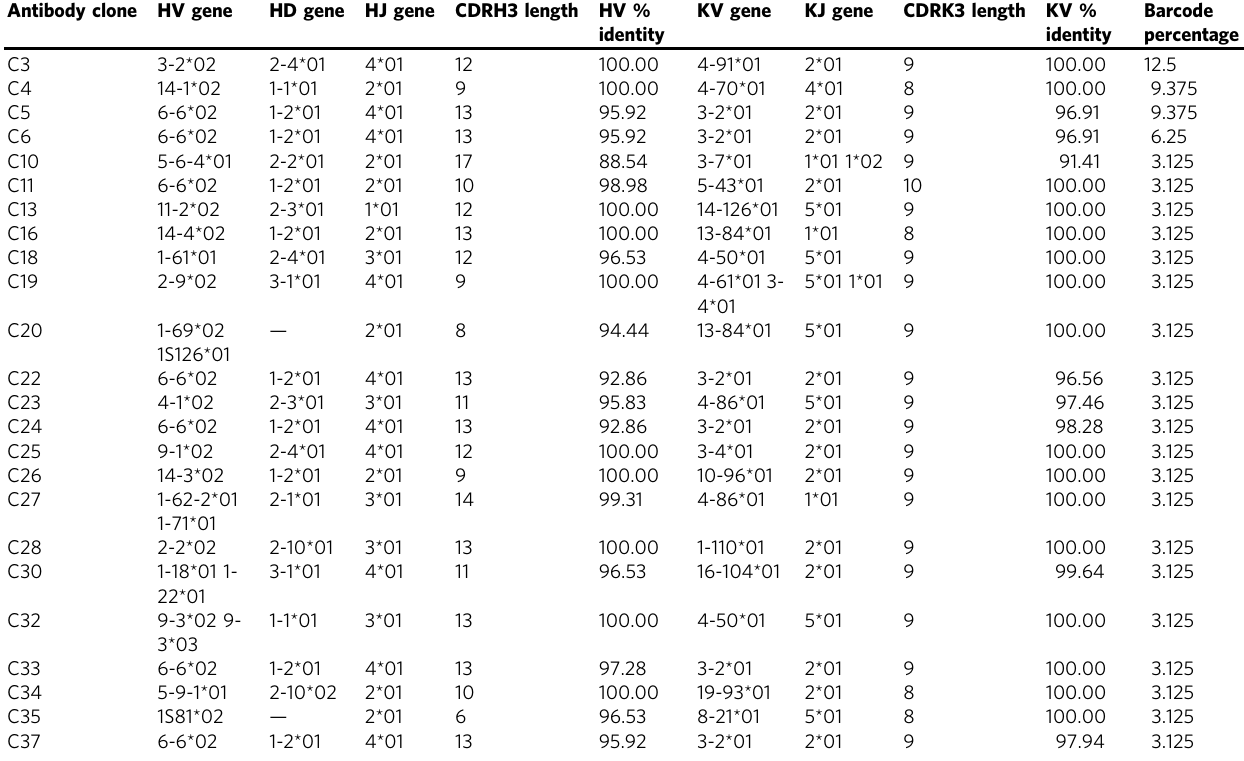
Table 1 Detailed characterization of isolated murine BG505.MD39-speci fi c clones in terms of VH, VJ, VD, VK, VK, VJ gene usage, HCDR3 and LCDR3 lengths. Antibody clone HV